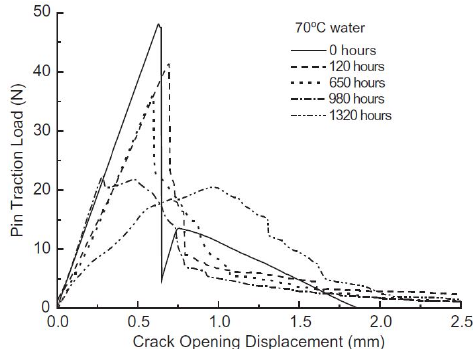
Figure 35. Pull-out load-displacement curve of z-Pins with time exposure in 70 ◦ C water environment (CFRP z-Pins, 4.0 vol%, d = 0.28 mm, pseudo-quasi-isotropic pre-preg, t = 4.5mm) [38].